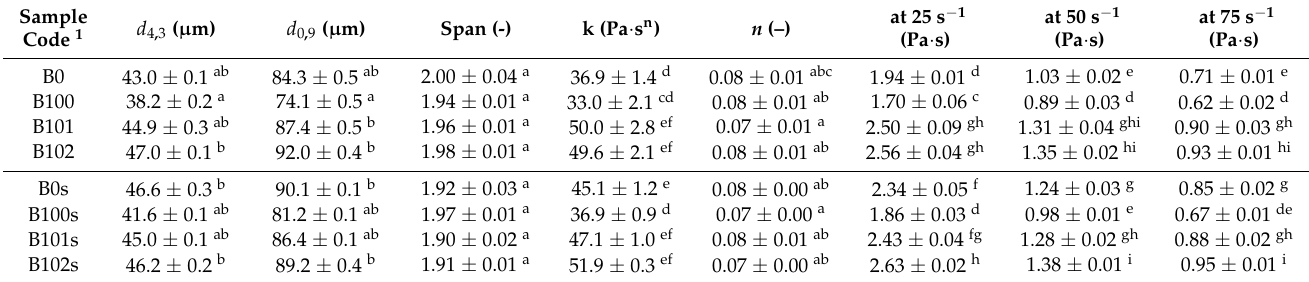
Table 4. The results of the volume PSD (d 4,3 , d 0,9 , Span) and summary of parameter values related to flow (the parameters of the Ostwald-de-Waele model k and n , and the viscosity at shear rate of 25,